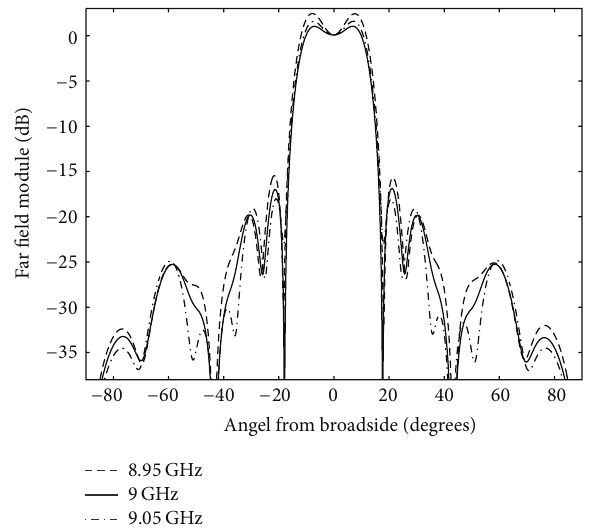
Figure 16: Ripple of the 10 × 10 planar array with an arrow-shaped radiation pattern in the u - v plane (expressed in dB).